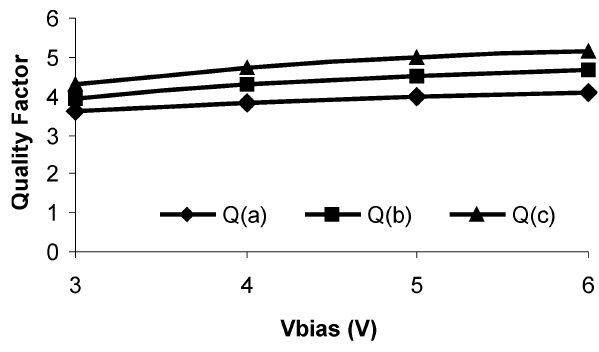
FIGURE 16 Different resonator configurations: